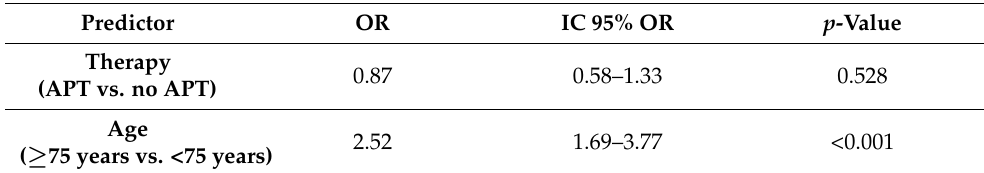
Logistic Model 4 (Multivariate Analysis)—Predictors: Therapy Adjusted for Age (Age Categorized: Age ≥ 75 Years vs. Age < 75 Years)